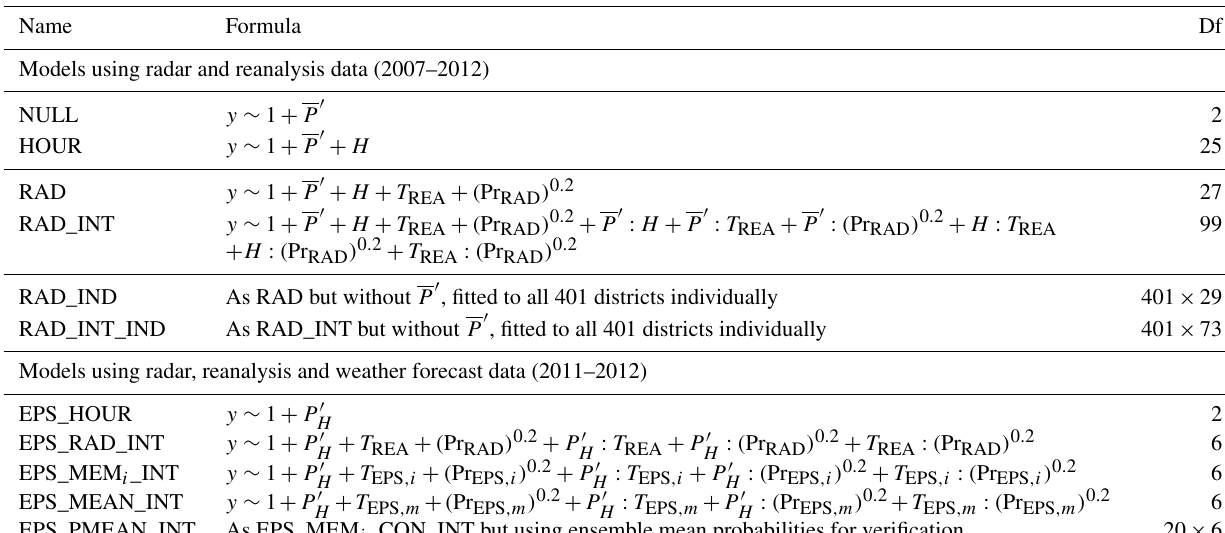
Table 2. Description of different logistic regression models for hourly probabilities of weather-related road accidents in German administra- tive districts and their degrees of freedom (Df). Formulas are written using the statistical formula notation system as used in programming languages like R and Python, with colons indicating interaction terms. See Table 1 for a definition of